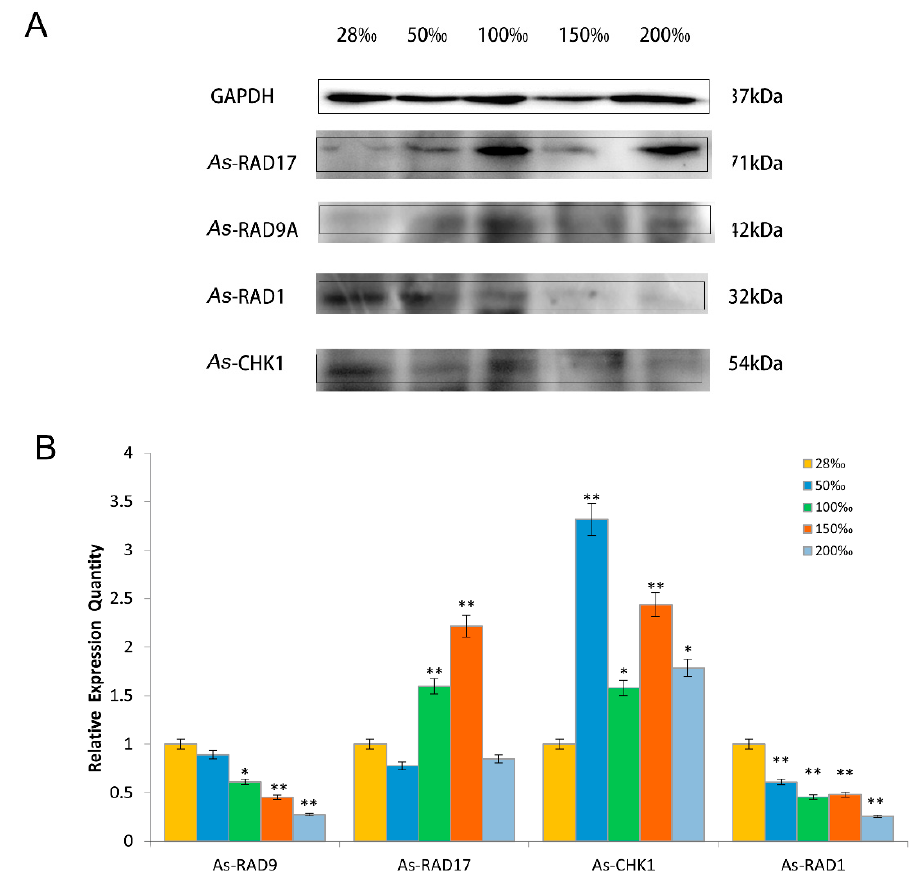
Figure 7. Western blot analyses of As– RAD9, As– RAD17, As– RAD1, and As– CHK1 proteins of A. sinica under different salt concentration stresses. ( A ) The band intensity of the protein is normalized to GAPDH. ( B ) The values are expressed as an arbitrary unit of relative value. The expression of the protein at a salinity of 28‰ as control (yellow), and asterisk (**) indicates a statistically significant difference of P < 0.01, and (*) indicates a 0.01 < P < 0.05.